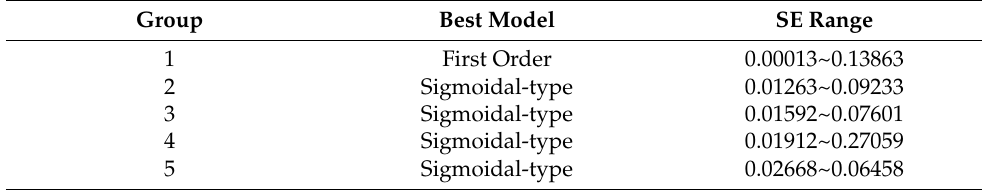
Table 2. Best model for each group according to the standard errors of regression (SE) and their